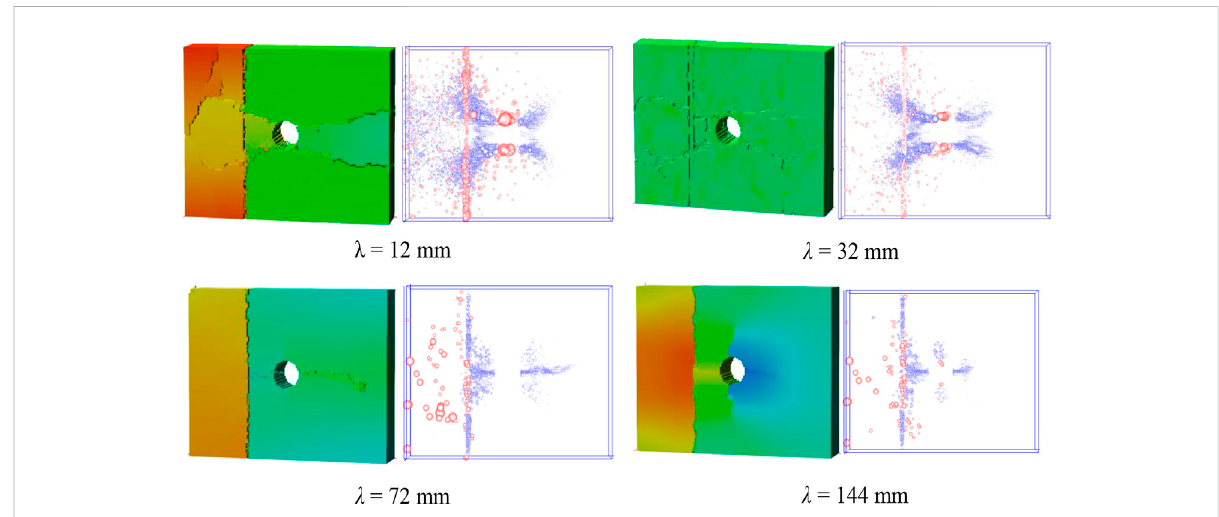
FIGURE 16 Failure patterns and AE distribution of jointed rocky with a pre-existing hole under different